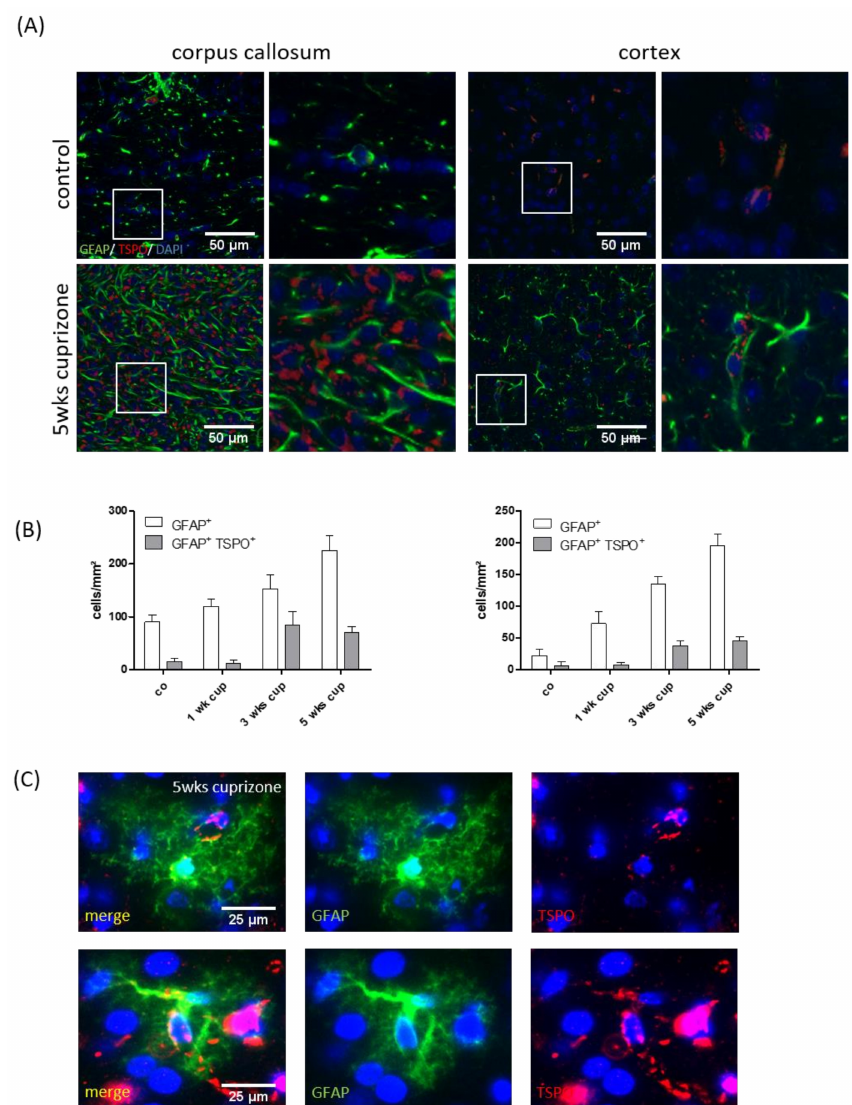
Figure 6. Co-localization of TSPO with the astrocyte marker protein, GFAP ( A ). The representative images of GFAP (green) and TSPO (red) immunofluorescence double stains in the control and 5-week cuprizone-intoxicated mice (left: corpus callosum; right: cortex). The white boxes highlight cells which are shown on the right-hand side at higher magnification. ( B ) The quantification of the entire GFAP + cell densities (white columns) and GFAP + /TSPO + double positive cell densities (grey columns) in the control animals ( n = 4) and the animals intoxicated with cuprizone for one ( n = 5), three ( n = 5) or five ( n = 5) weeks. ( C ) The representative images demonstrating expression of TSPO (red) in eGFP-expressing astrocytes